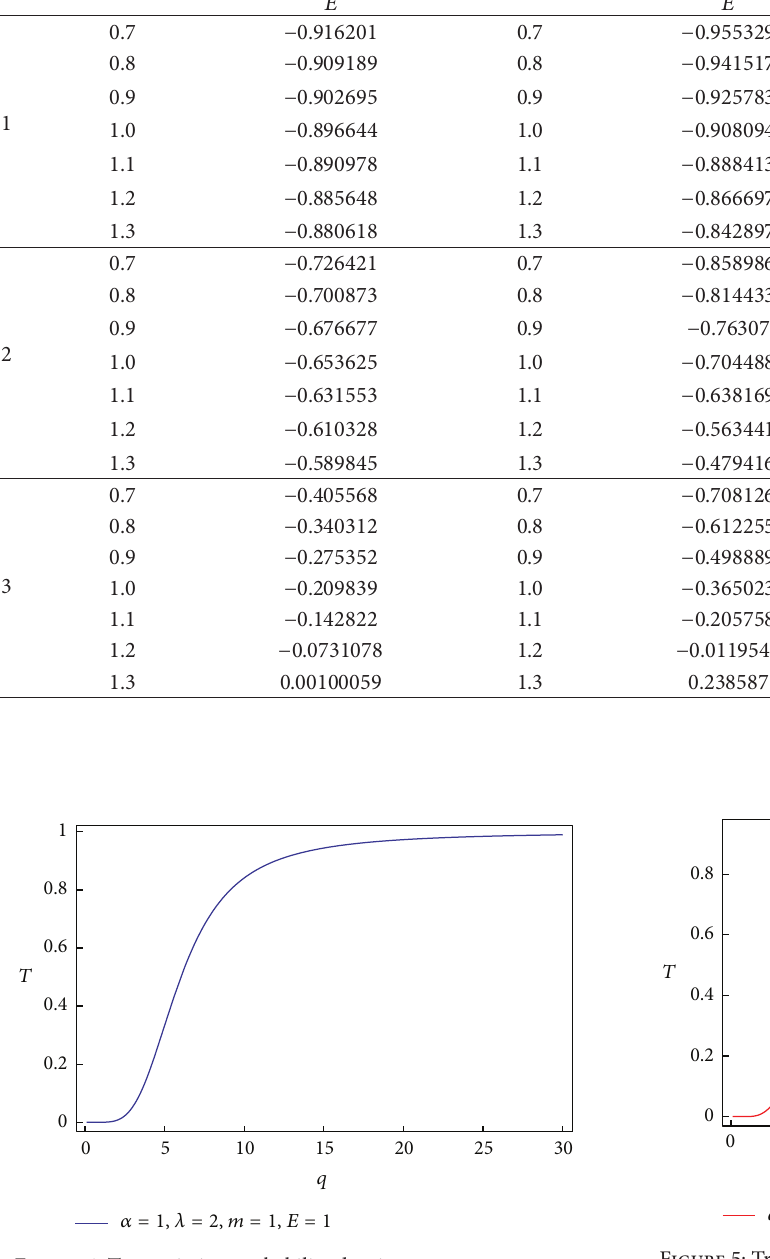
Figure 4: Transmission probability density versus 𝑞 parameter. Figure 5: Transmission probability density versus